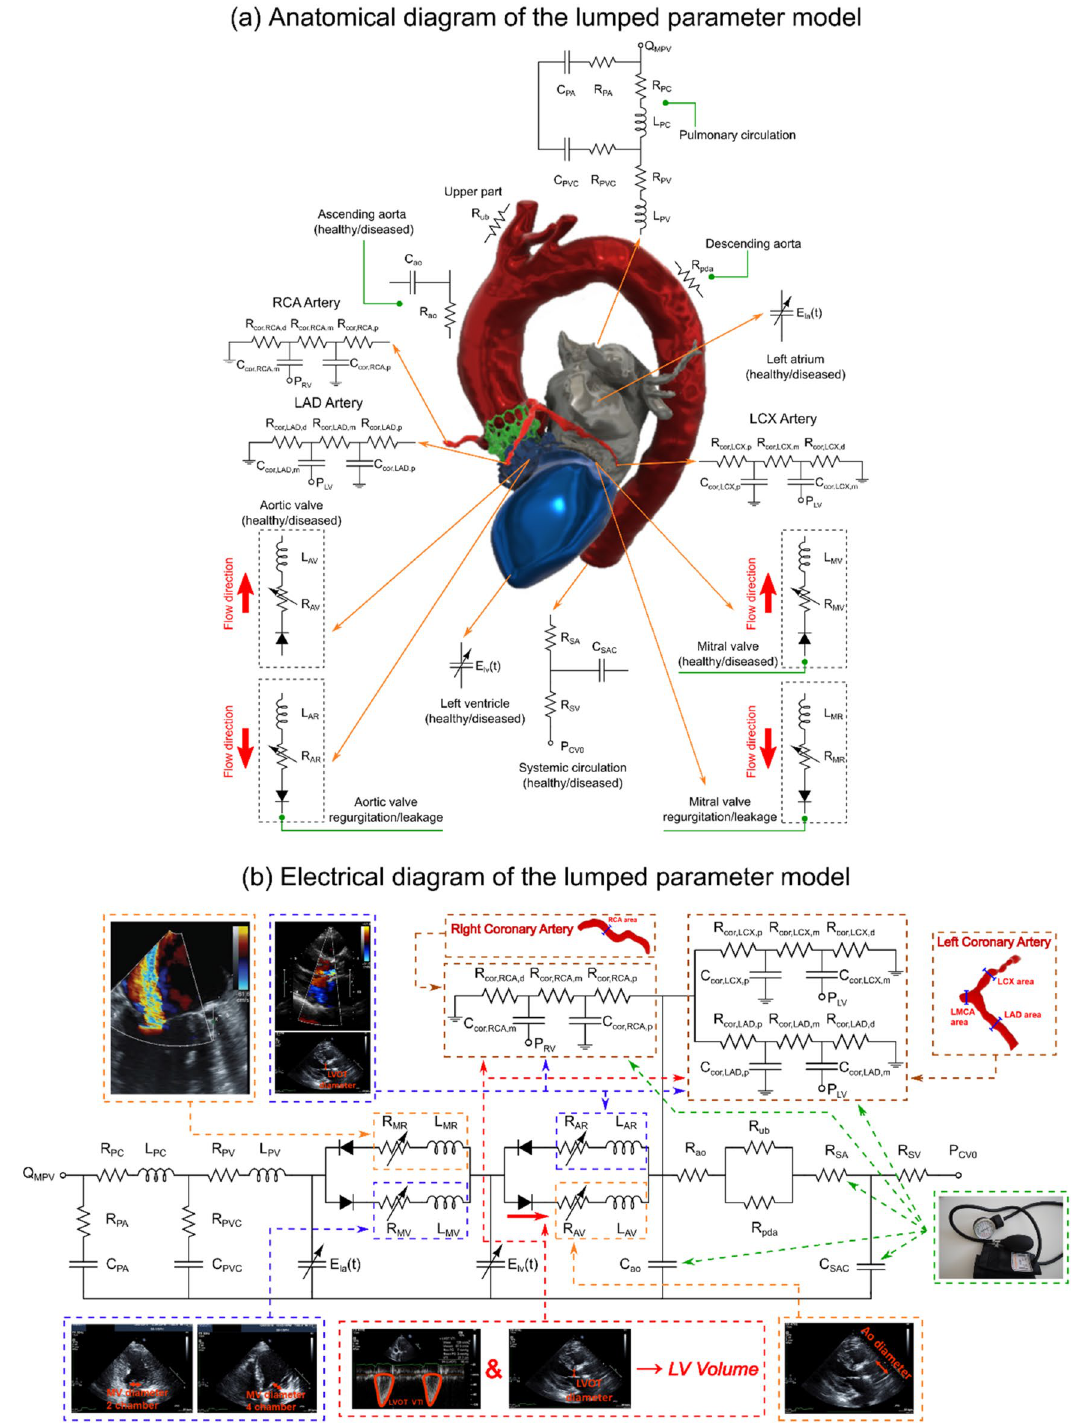
Figure 1. Electrical and anatomical schematic diagrams of the lumped parameter modeling. ( a ) Anatomical illustration; ( b ) Electrical depiction. This model includes the following sub-models: left main coronary artery, left anterior descending coronary artery, left circumflex coronary artery and right coronary artery, left ventricle, aortic valve, left atrium, mitral valve, aortic valve regurgitation, mitral valve regurgitation, systemic circulation, pulmonary circulation. Abbreviations are the same as in Table